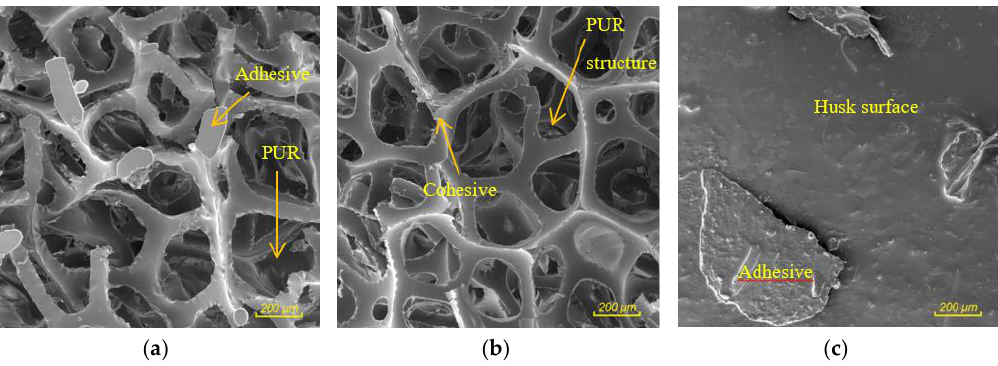
Figure 7. Nature of bond failure after internal bond strength test: ( a ) adhesive failure between the husk and PUR particle; ( b ) cohesion failure in PUR particle; ( c ) adhesive failure between the adhesive and husks surface.